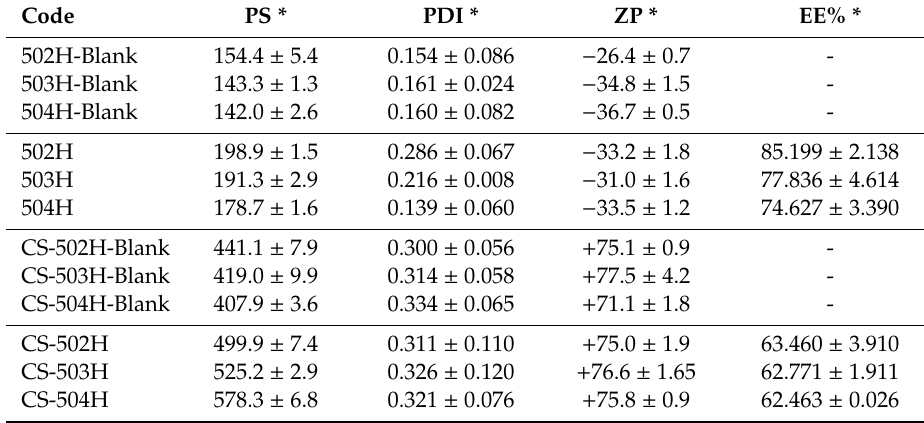
Table 2. Particle size (PS), polydispersity index (PDI), zeta potential (ZP), and entrapment e ffi ciency (EE%)